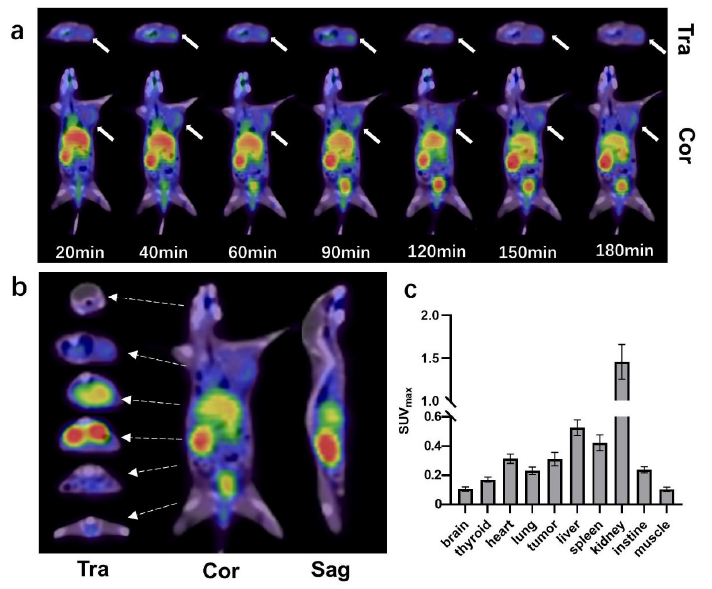
Figure 3. ( a ) PET/CT imaging of 68 Ga-WL12 in PANC02-bearing mice at 20, 40, 60, 90, 120, 150, and 180 min post injection. Top row, transverse images (Tra); second row, coronal images of tumors (Cor). ( b ) Several representative cross-sectional images and the corresponding sagittal (Sag) and coronal images at 90 min post injection. ( c ) SUV max of critical organs in PANC02-bearing mice ( n = 3) at 90 min post injection.